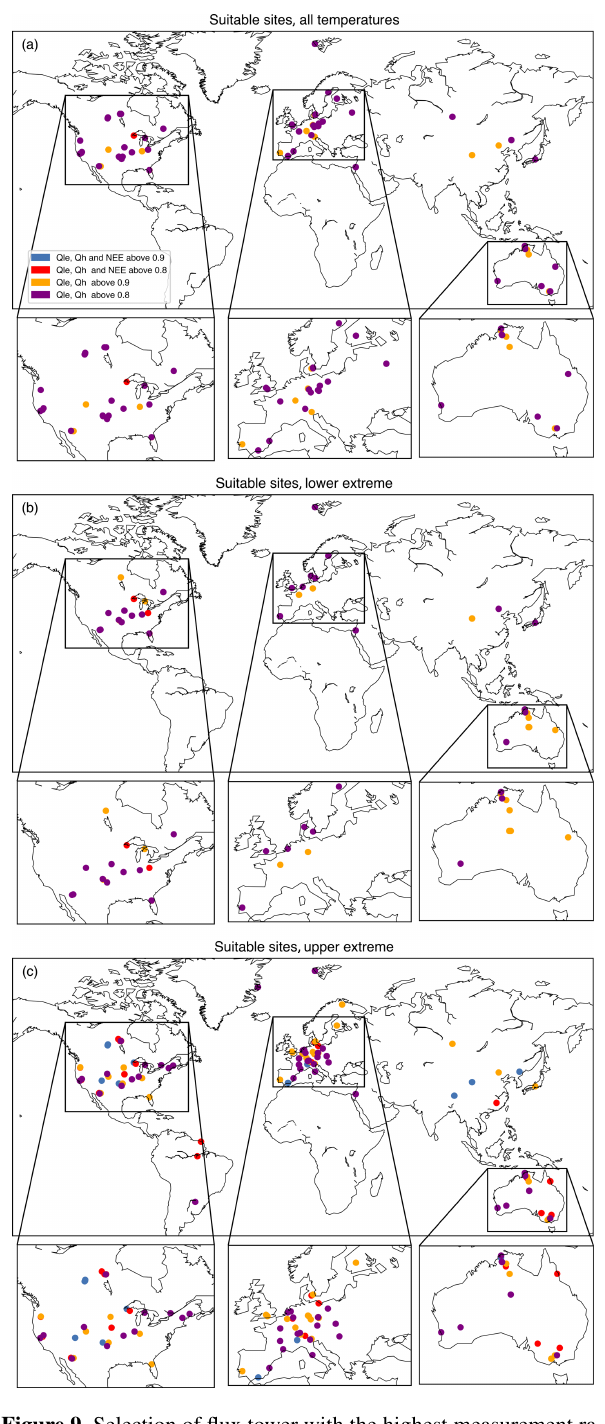
Figure 9. Selection of flux tower with the highest measurement ra- tios for all temperatures. Sites are selected where Q le , Q h and NEE measurement ratios are all above 0.9 or 0.8, and separately where Q le and Q h are above 0.9 or 0.8. Panel (a) shows sites for all tem- peratures, (b) for lower extreme temperatures and (c) for upper ex- treme